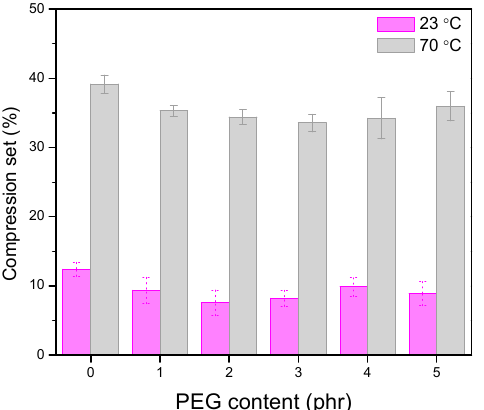
Figure 11. Effect of PEG contents on compression set at 23 °C and 70 °C.